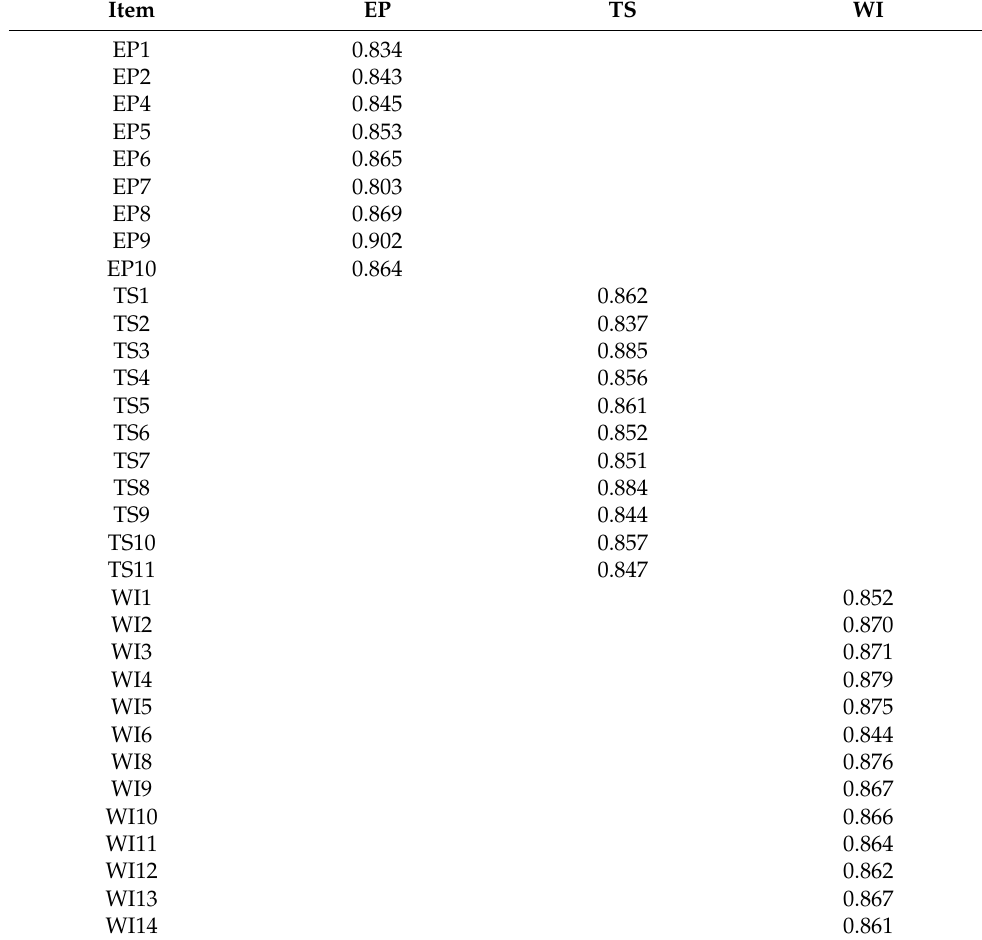
Table 3. Revised CFA (outer